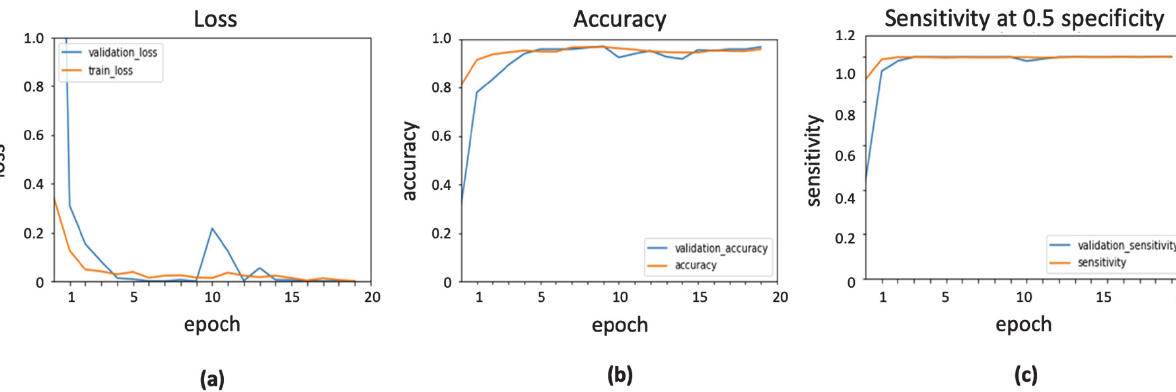
Figure 6. Output obtained using ADADelta optimizer: ( a ) loss function; ( b ) accuracy; ( c ) sensitivity.